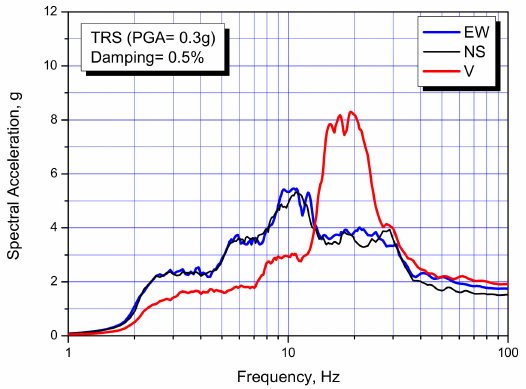
Figure 16. Test response spectrum of shaking table